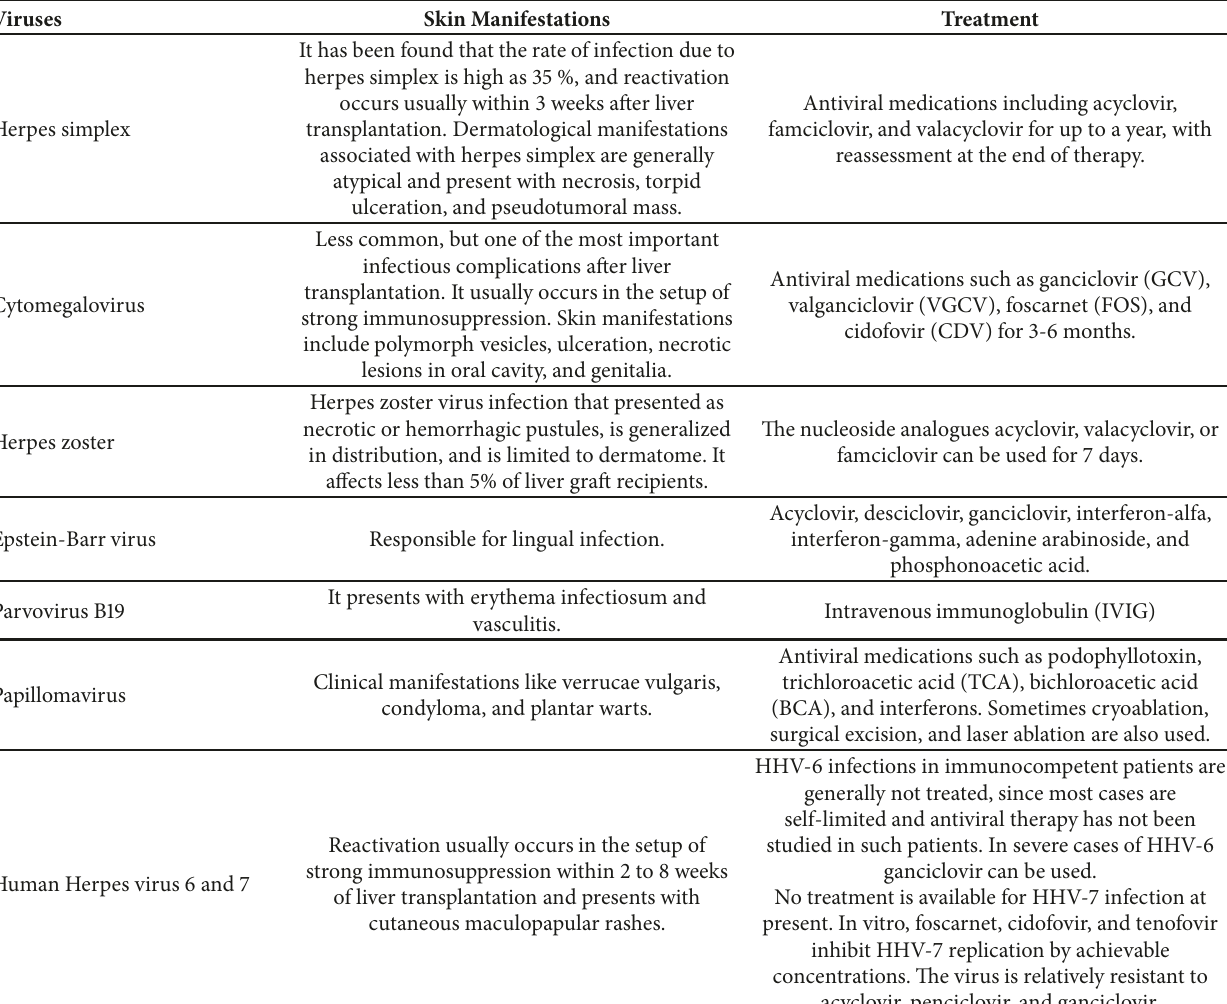
Table 4: Viral skin infection after liver